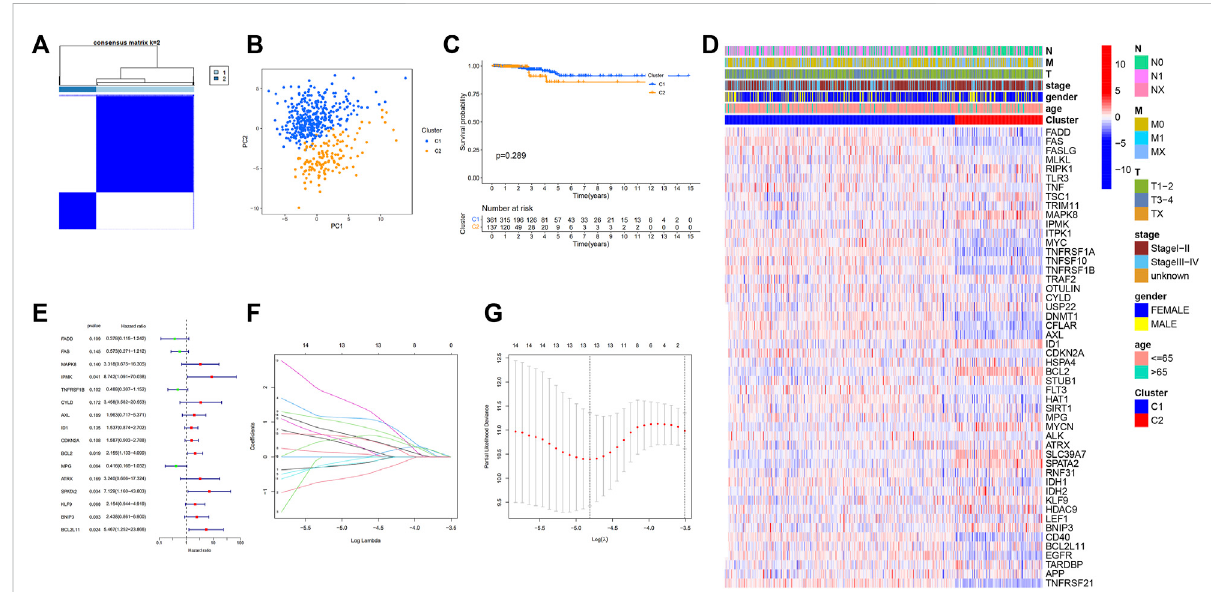
FIGURE 2 Tumor classi fi cation based on the necroptosis-related DEGs; Univariate Cox regression analysis and LASSO analysis. (A) 498 PTC patients were grouped into two clusters according to the consensus clustering matrix ( k = 2); (B) Principal Component Analysis (PCA) of RNA expression pro fi le in TCGA cohort; (C) Kaplan – Meier curves of overall survival (OS) in two clusters; (D) Heatmap and clinicopathologic features of the two clusters; (E) Forest plot showing the result of univariate Cox regression analysis of OS, 16 genes with p < 0.2; (F) Cross-validation for tuning parameter selection in LASSO regression (G) LASSO analysis of 16 prognostic pyroptosis-related